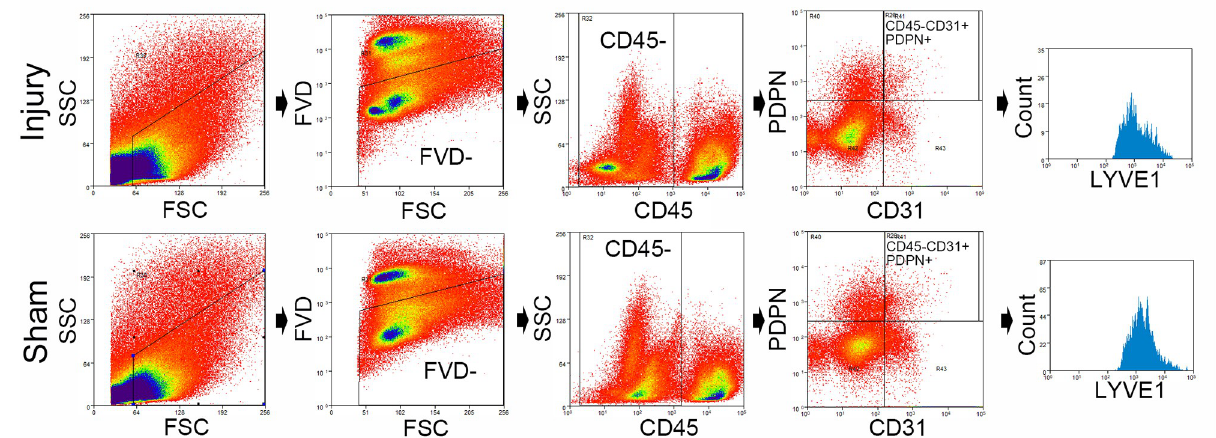
Fig 2. Isolation of meningeal lymphatic endothelial cells (LECs) via flow cytometry. Representative dot and contour plots showing the gating strategy used to isolate LECs via flow cytometry from the meninges of mice with traumatic brain injury and the sham mice. The cell count graph shows the number of cells, which were gated by CD45 − CD31+PDPN+, labeled with the anti-LYVE1 antibody.